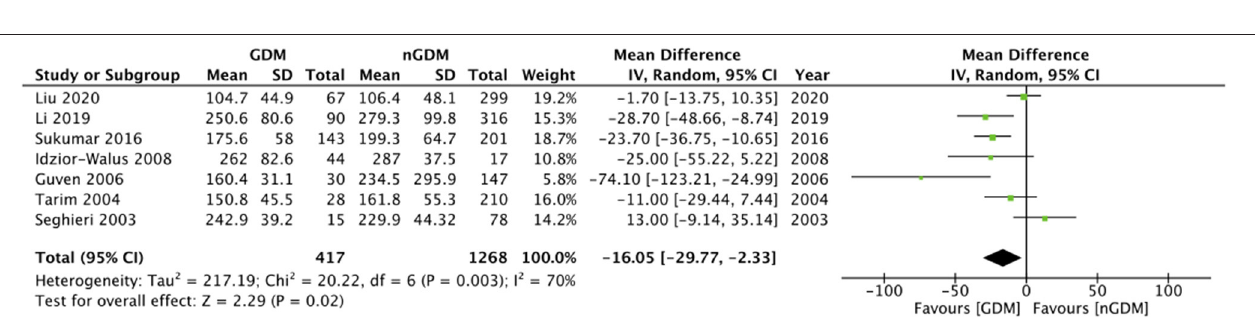
FIGURE 2 | Meta-analysis of serum folate concentration during pregnancy between GDM and non-GDM groups.